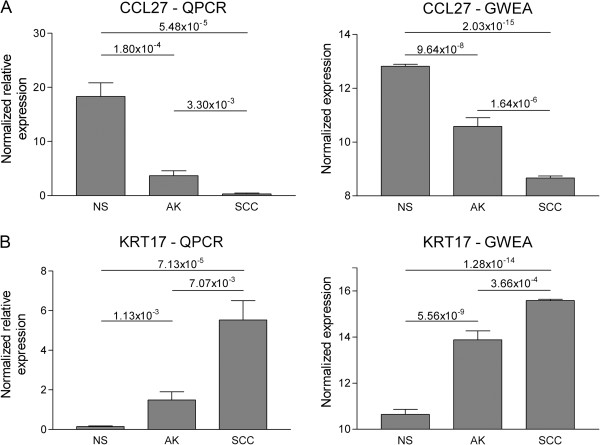
QPCR and genome-wide expression analysis (GWEA). (A) Histograms showing the expression level of CCL27 in NS, AK and SCC samples measured by QPCR (left) and GWEA (right). (B) Histograms showing the expression level of KRT17 in NS, AK and SCC samples measured by QPCR (left) and GWEA (right). For QPCR the normalized relative expression level represents the expression of the gene of interest normalized to those of four reference genes. For the GWEA the normalized expression level represents the RSN normalized, VST transformed expression of the gene of interest.